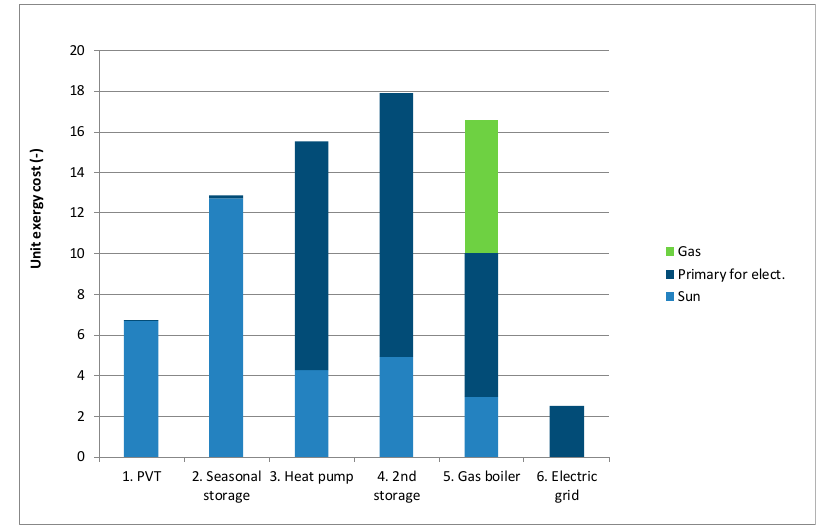
Figure 16. Cost formation by source: Year basis.